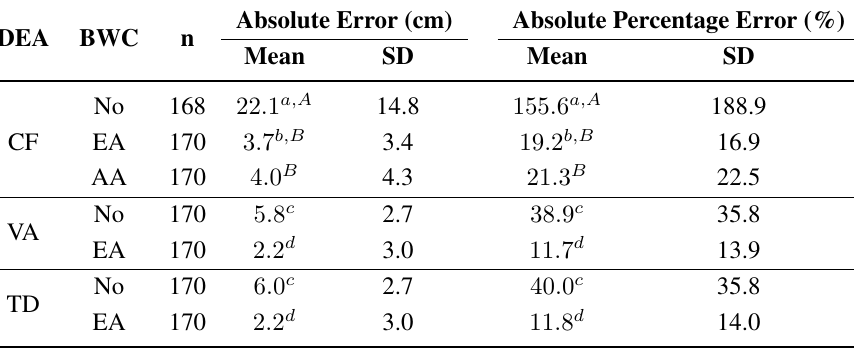
Table 3. Mean estimation error and standard deviation (SD) for all tested combinations of diameter estimation algorithm (DEA) and beam width compensation (BWC) methods, using the MD multiple scan methods with 10 scans. Within columns, different superscripted lowercase letters indicate significant differences ( p < 0 . 05 ) between the six combinations of algorithms and BWCs No and EA (two-way ANCOVA with Tukey test for Ln-transformed error values). Different superscript uppercase letters within columns indicate significant differences between BWCs within the CF algorithm ( p < 0 . 05 ) (One-way ANOVA with Tukey